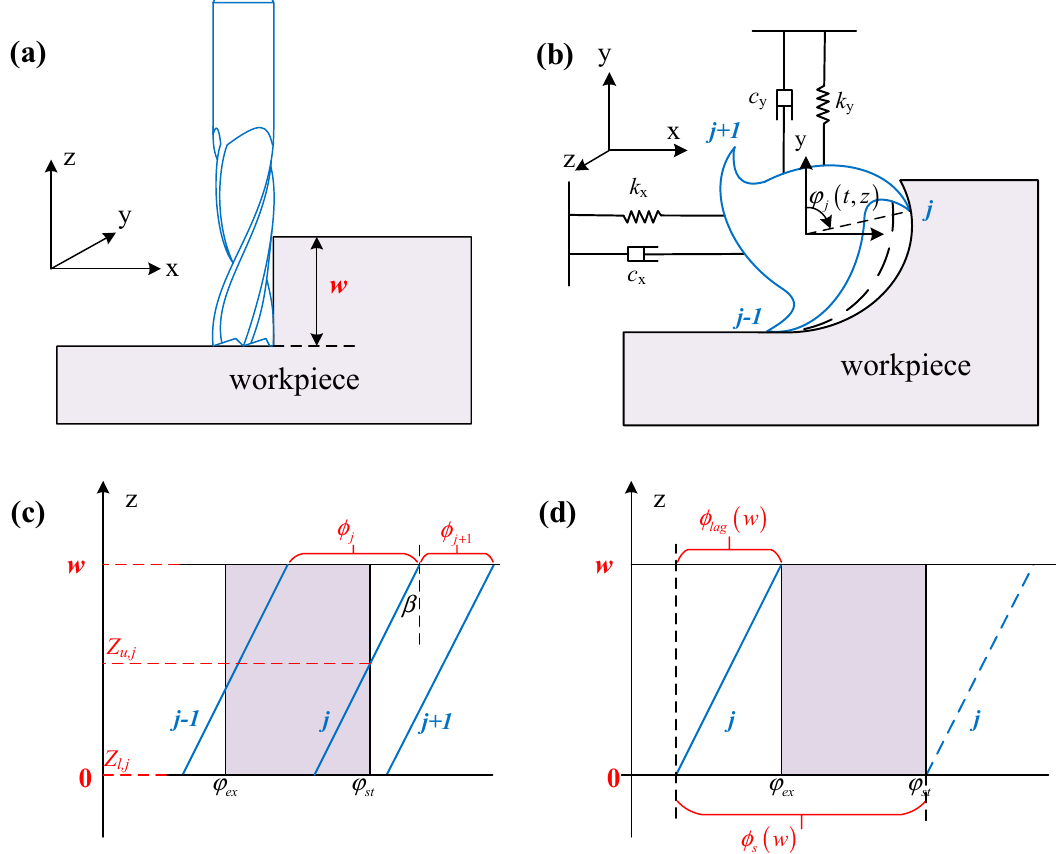
Figure 1. Schematic of two-degree of freedom (DOF) milling model with variable pitch milling cutter, ( a ) schematic of milling model; ( b ) z-direction view; ( c ) distribution of the cutter teeth; ( d ) the lag angle and tooth sweep angle.